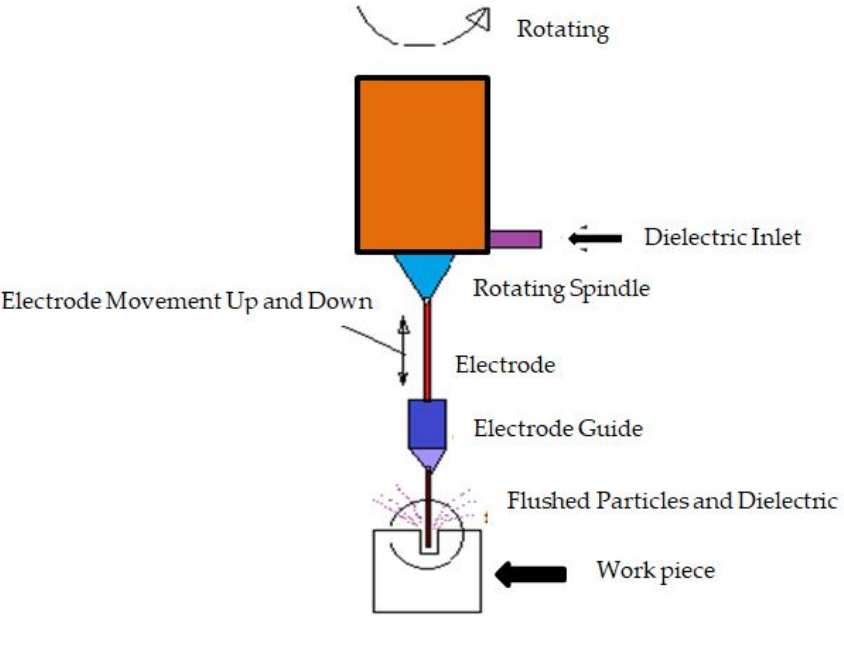
Figure 4. Fast hole drilling EDM.